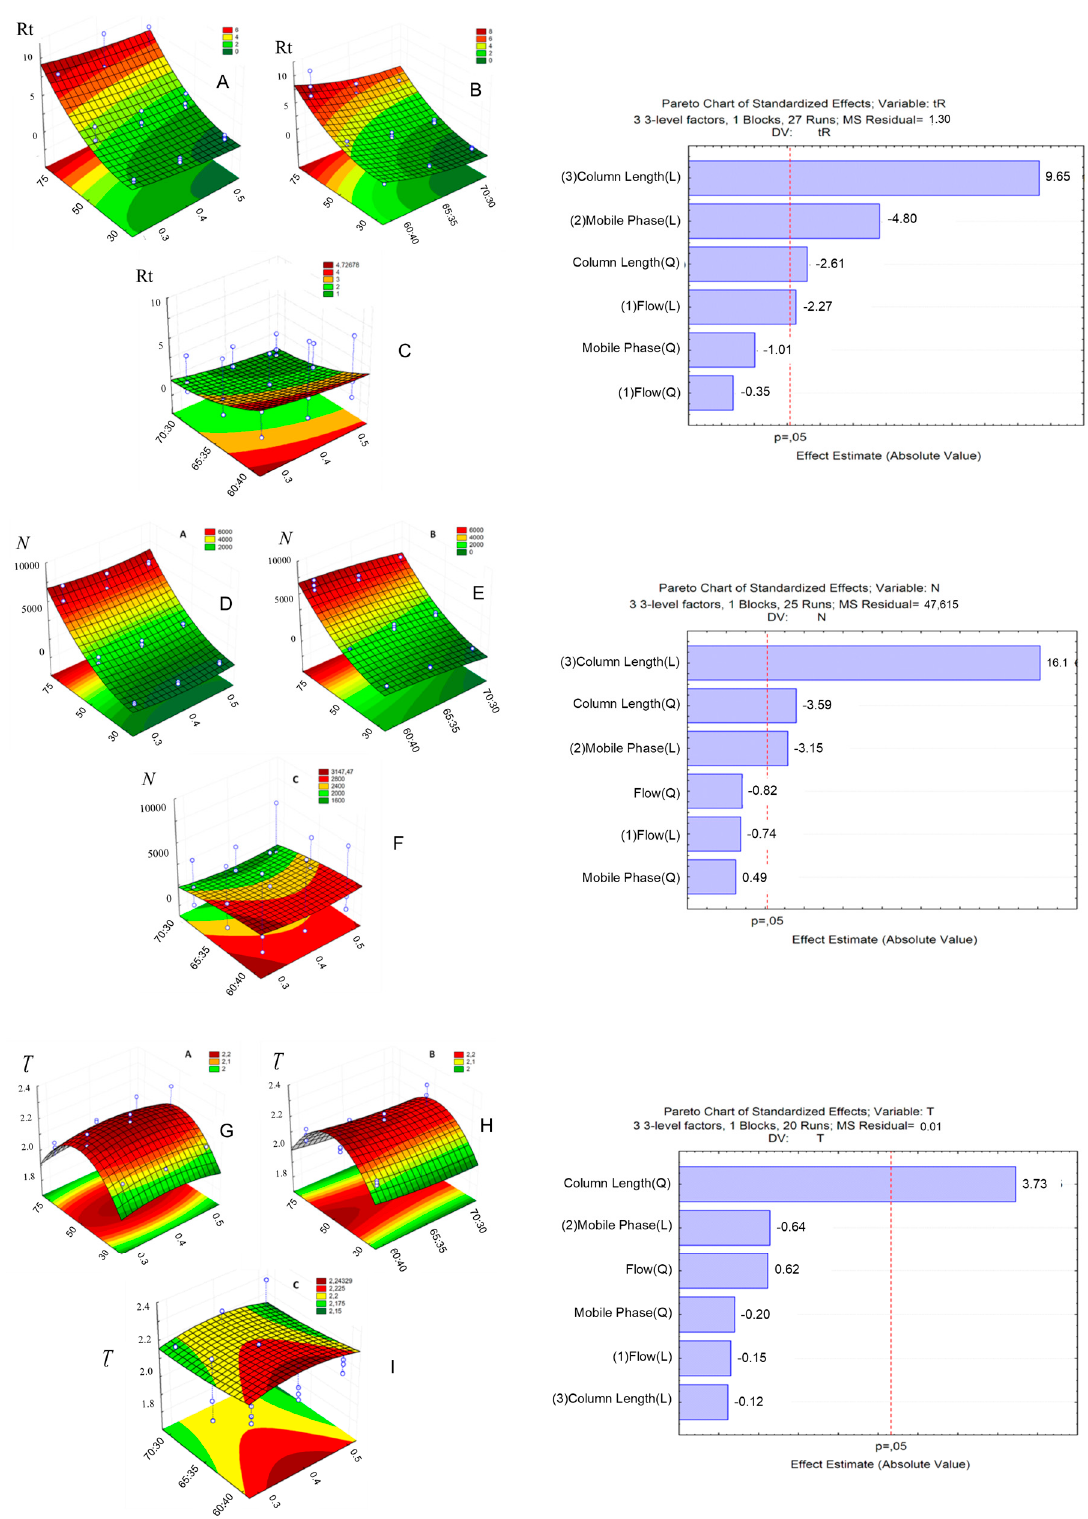
Figure 3. Factorial experimental design to UHPLC method development. The effects Rt ( A )–( C ), N ( D )–( F ), Ʈ ( G )–( I ) and response surface and Pareto graphs.